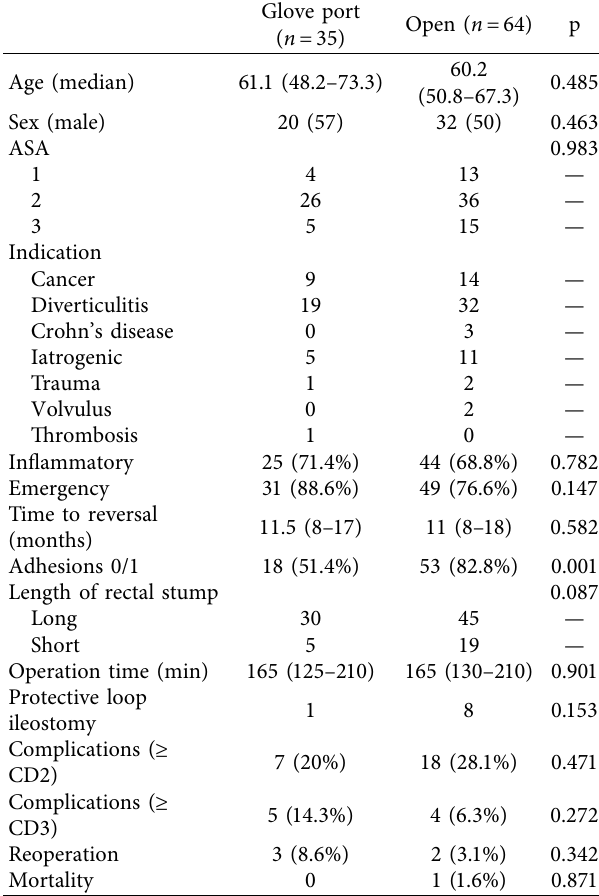
Table 1: Demographic data for glove port and open approach. Combined and converted operations were